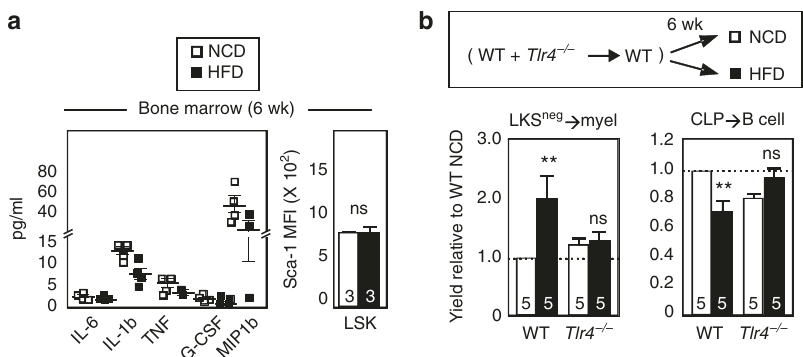
Fig. 5 Requirement for BM cell-autonomous TLR4 in HFD-induced myeloid bias. a Left, cytokine levels in BM were assessed via multiplex ELISA following 6 weeks of 60 kcal% high-fat or control diet. NCD/HFD cohorts were examined in parallel and each symbol is a different animal. The thresholds of detection are: IL-6, 0.4 pg/ml; IL-1b, 5.4 pg/ml; TNF, 0.5 pg/ml; G-CSF, 0.5 pg/ml; MIP1b, 11.9 pg/ml. Right, Sca-1 mean fl uorescence intensity (MFI) on BM-LSK. Data are analyzed by Student ’ s t-test. Error bars represent s.e.m. b WT (CD45.1) or Tlr4 − / − (CD45.2) BM was mixed and co-transferred to CD45.1/2 recipients, after which mice were rested for one week and then fed 60 kcal% high-fat or control diet for 6 weeks. At sacri fi ce, LKS neg and CLP subsets from each donor were sorted for analysis of outgrowth potential as in Fig. 2. Data are pooled from two independent experiments performed with different BM donors and 2 – 3 recipients/experiment. Bar graphs depict average ± SEM, with number of mice inset. Data are analyzed by Student ’ s t-test with Bonferroni correction for multiple comparisons. ** p < 0.05; ns, not signi fi